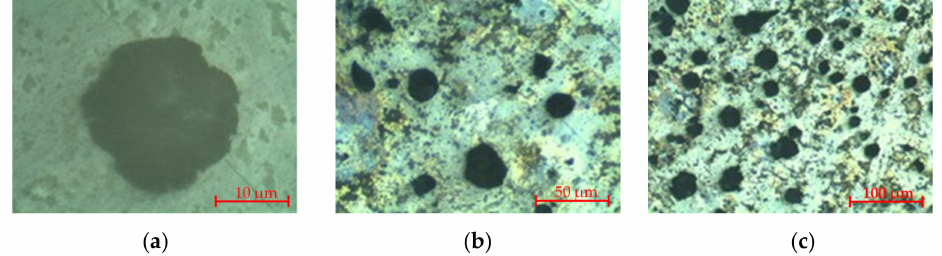
Figure 2. The microstructure of cast iron with nodular graphite and the ferrite-pearlitic metallic base: ( a ) 500 × ; ( b ) 200 × ; ( c ) 100 ×